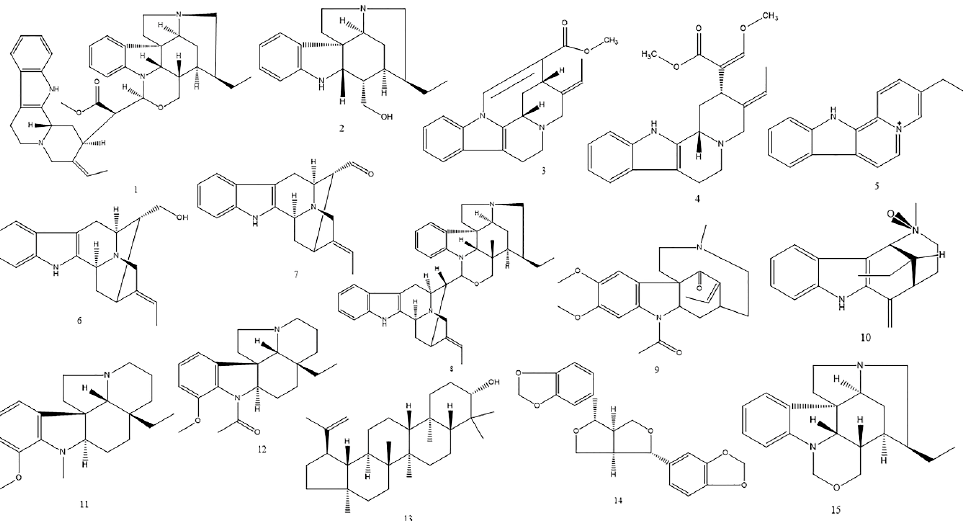
Figure 1. Main compounds isolated from G. vellosii . (1.1) Geissospermine [7]; (1.2) geissoschizoline;